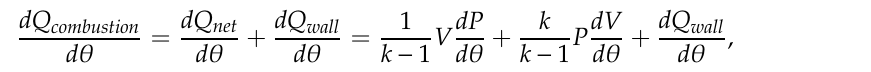
Figure 7. CP changes for biodiesel with loads at 21, 24 and 27° bTDC. Adapted with permission from